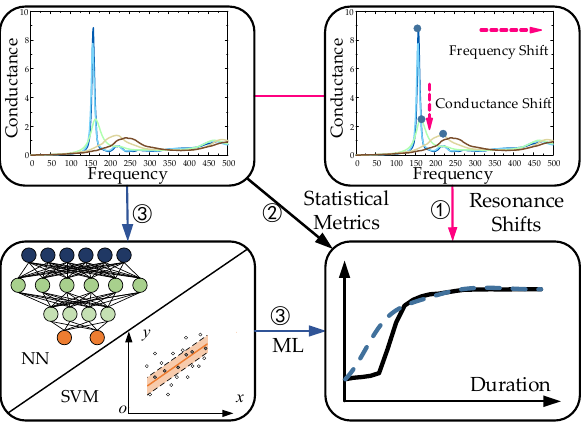
Figure 1. Flowchart of the EMI-based approaches for concrete strength gain prediction.